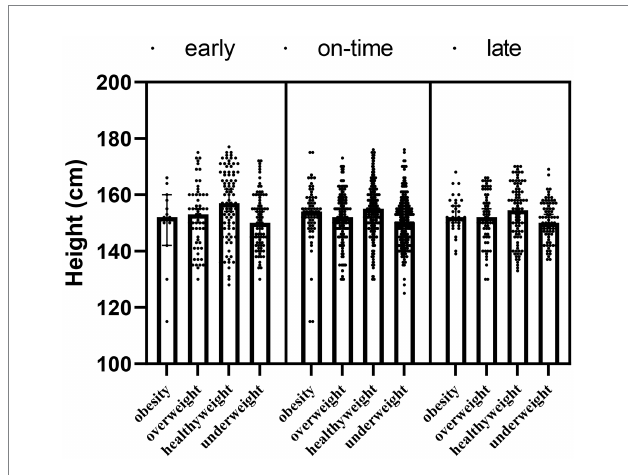
FIGURE 3 The height of participants according to maturity and obesity